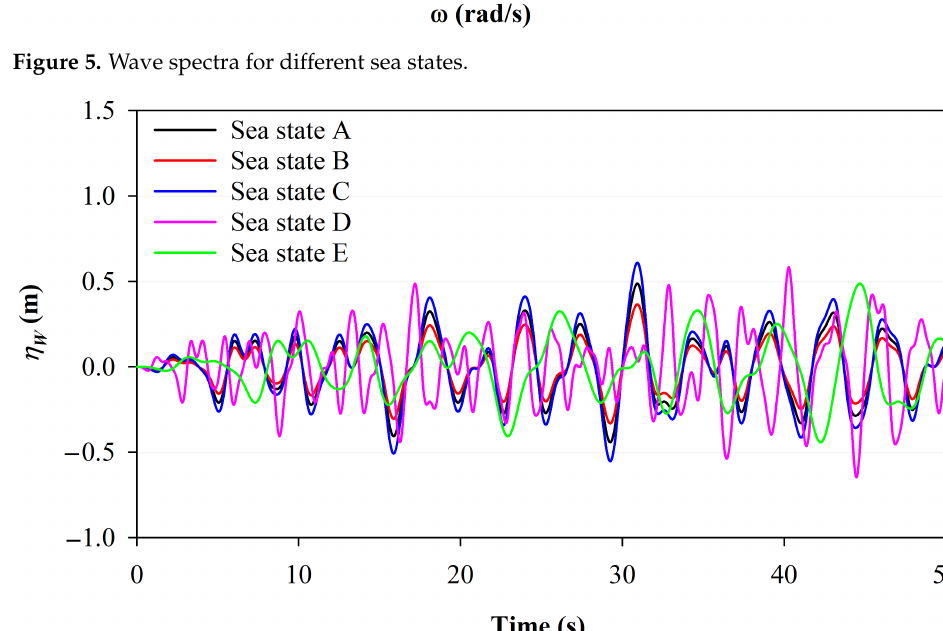
Figure 6. Examples of five different irregular wave profiles for 50 s time